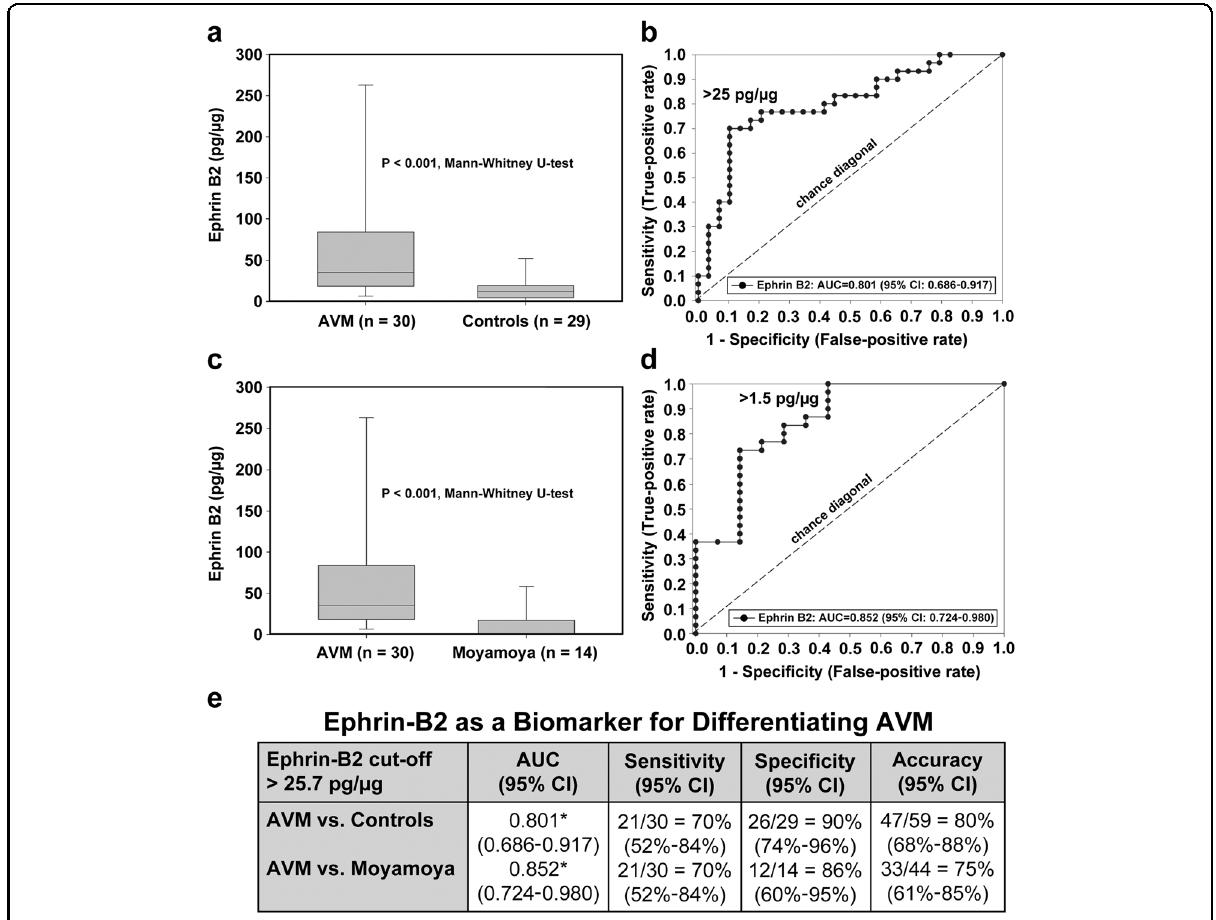
Fig. 5 EphrinB2 as a biomarker of pediatric AVM: Urinary EphrinB2 distinguishes AVM patients from controls and from patients with other cerebrovascular disease. a Urinary levels of EphrinB2 are capable of distinguishing patients with AVM from healthy matched controls ( p < 0.001). The median levels of urinary EphrinB2 were 35.0 pg/µg (IQR 18.4 – 84.1) for AVM patients and 11.7 pg/µg (IQR 4.4 – 19.1) for controls. b Regression modeling demonstrated that urinary biomarkers can predict the presence of AVM with high speci fi city and sensitivity. A urinary EphrinB2 value > 25 pg/ μ g was seven times more likely to be present in patients with AVM (AUC 0.801, 95% CI) than it was in controls, and this result was independent of age and sex. c Example of the ability of urinary biomarkers to discriminate between different types of CNS vascular disease. By univariate analysis, levels of urinary EphrinB2 could distinguish between patients with AVM and other cerebrovascular disease (moyamoya) ( p < 0.001). The median levels of urinary EphrinB2 were 35.0 pg/µg (IQR 18.4 – 84.1) for AVM patients and 0.0 pg/µg (0.0 – 17.2) for moyamoya patients. d Results of the regression modeling showed that a urinary EphrinB2 value > 25 pg/ μ g was fi ve times more likely to indicate AVM presence (AUC 0.852, 95% CI). e ROC analysis of EphrinB2 showed excellent discrimination when used as an independent marker for AVM versus control with 80% accuracy and AVM versus moyamoya with 75%